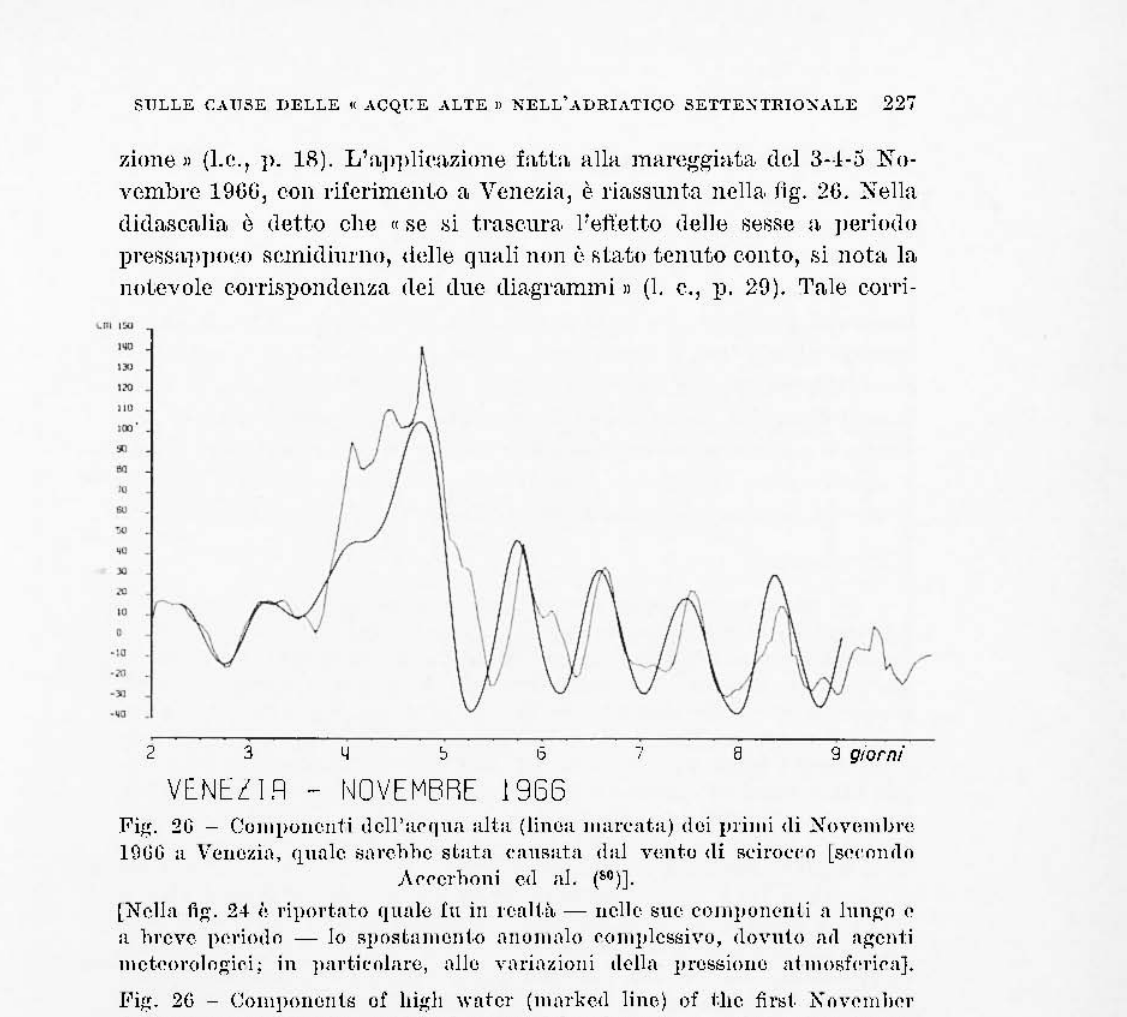
(Fig. 24 8how~, in its Ioni! amI shurt IJel'io(1 eOlllponentR, the total